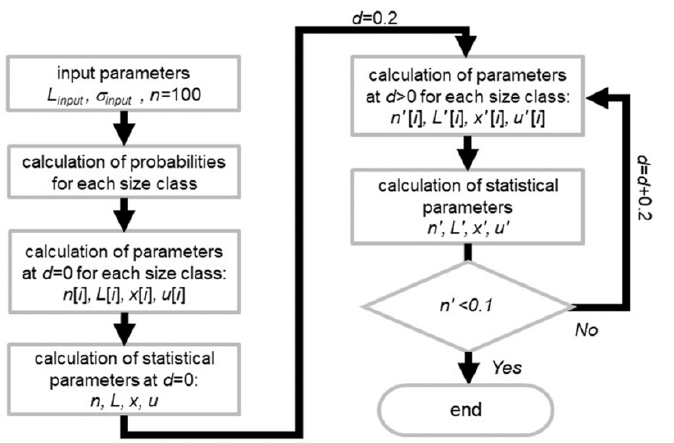
Figure 6. Flowchart of the calculation procedure. Many rounds of calculations are needed for larger nodules because the condition of n ′ < 0.1 is achieved when d is larger.